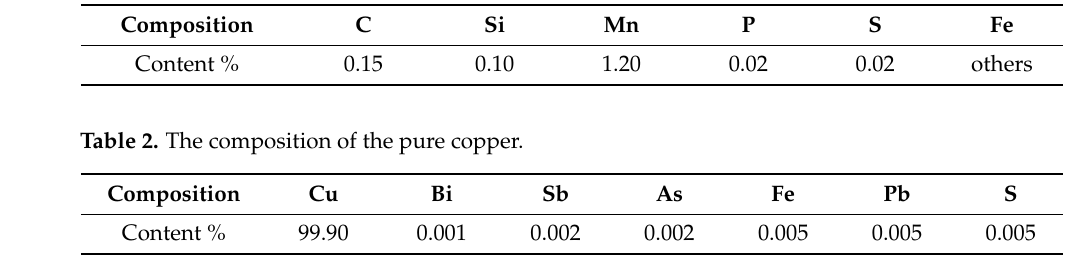
Table 1. The composition of the low-carbon steel.